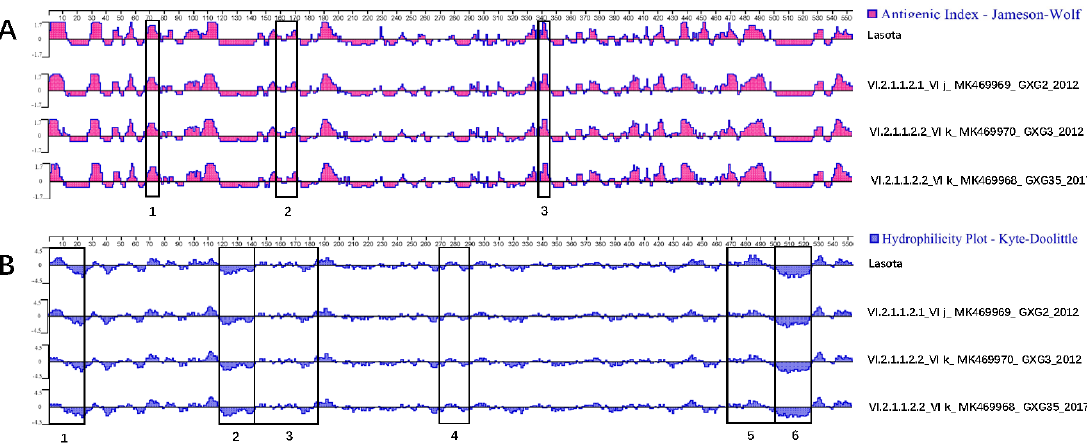
Figure 2. Comparison of the antigenicity and hydrophilicity of the F protein of selected PPMV-1 and LaSota vaccine. Protean module of Laser gene was used to analyze the antigenicity and hydrophilicity of fusion (F) protein of PPMV-1 isolates. GXG3 and GXG35 are representative isolates of sub-genotype VI.2.1.1.2.2, GXG2 is a representative isolate of sub-genotype VI.2.1.1.2.1, and LaSota vaccine is representative of genotype II vaccines. The pink diagram represents the antigenicity analysis of the F protein, and the blue diagram represents the hydrophilicity analysis of the F protein. The rectangular areas highlight the antigenicity and hydrophilicity differences in the F proteins between different viruses. ( A )1. neutralizing antigen epitope region (72aa, 78aa, 79aa); 2. neutralizing antigen epitope region (157–171aa); neutralizing antigen epitope region (343aa); ( B ) 1. hydrophobic region1, the signaling peptide region (1–25aa); 2. hydrophobic region 2, fusion induction region (117–142aa); 3. the seven-amino acid residue repeat region HRa (143–185aa); 4. the seven-amino acid residue repeat region HRc (268–289aa); 5. the seven-amino acid residue repeat region HRb (467–502aa); 6. hydrophobic region 3, transmembrane domain (500–521aa).